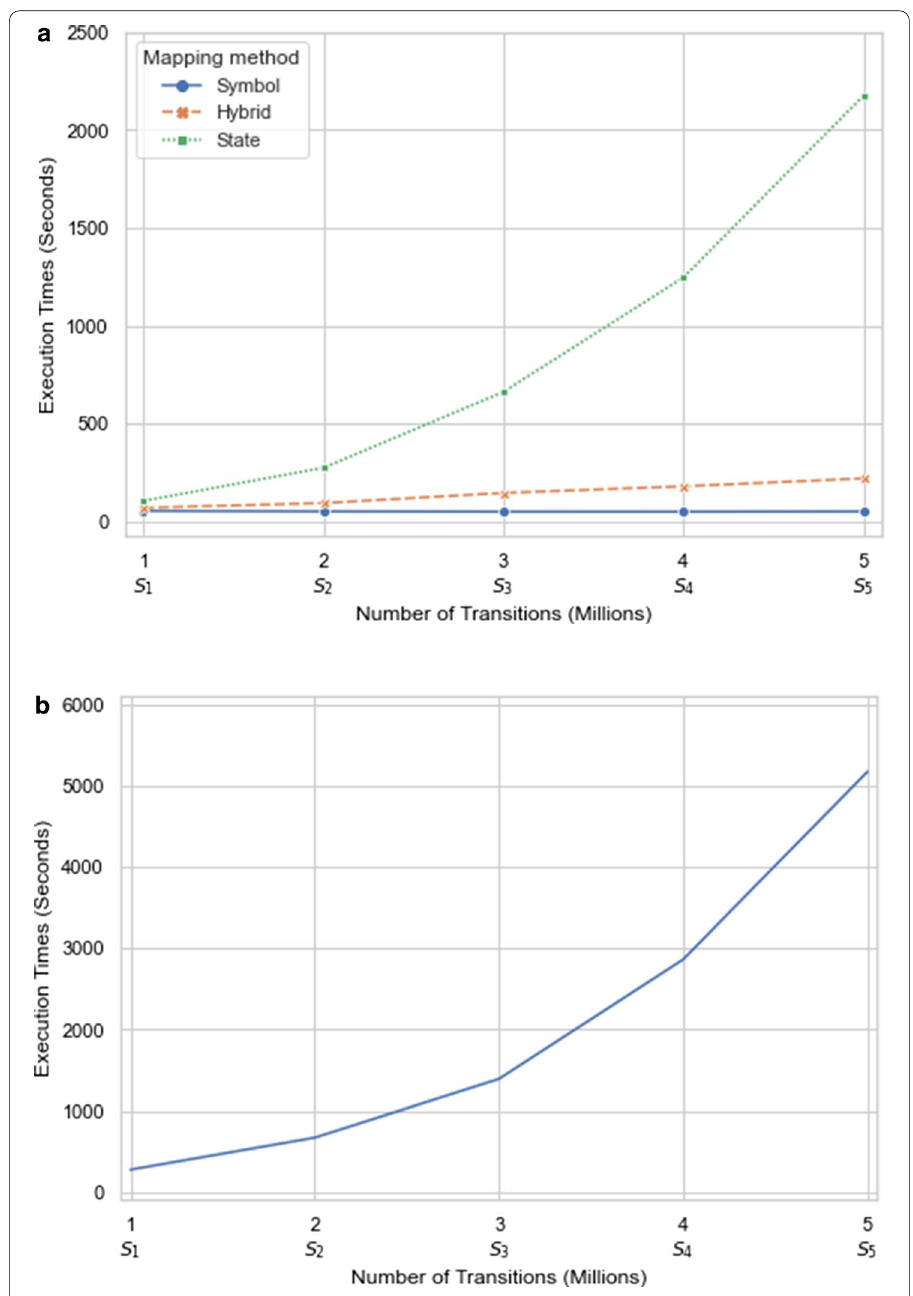
Fig. 10 Execution times versus the number of